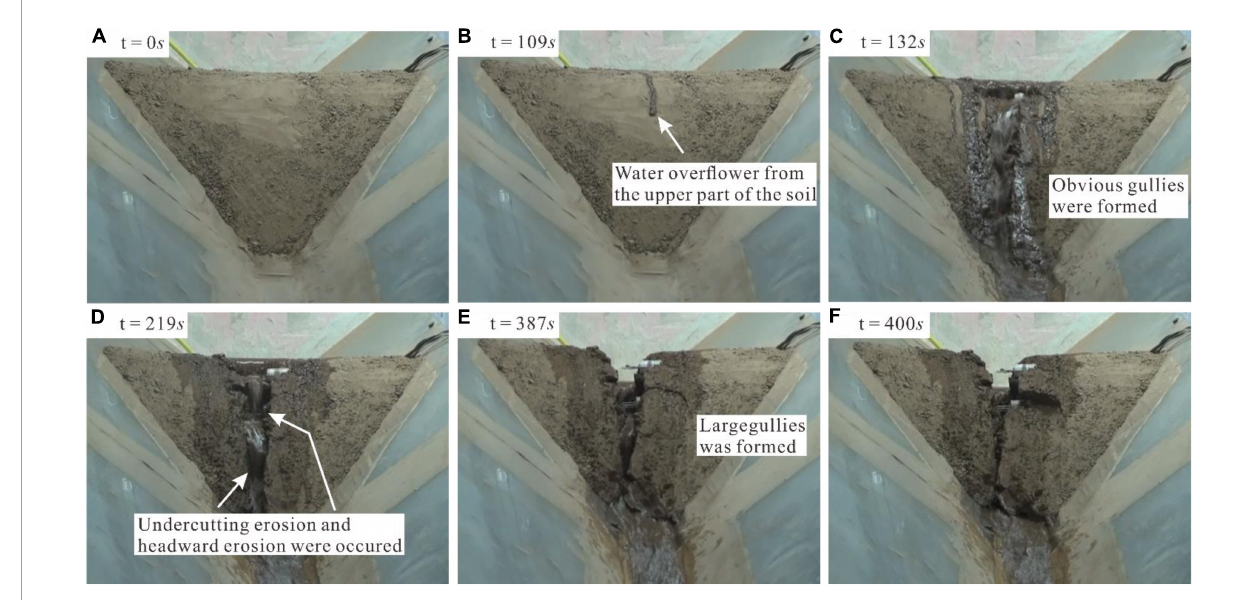
FIGURE4 The experimental process with the initial water content of 0%. In this figure describes the test process when the water content is 0%. For (A,F) , it is the beginning and result node of the test, and (B–E) is the important node in the test